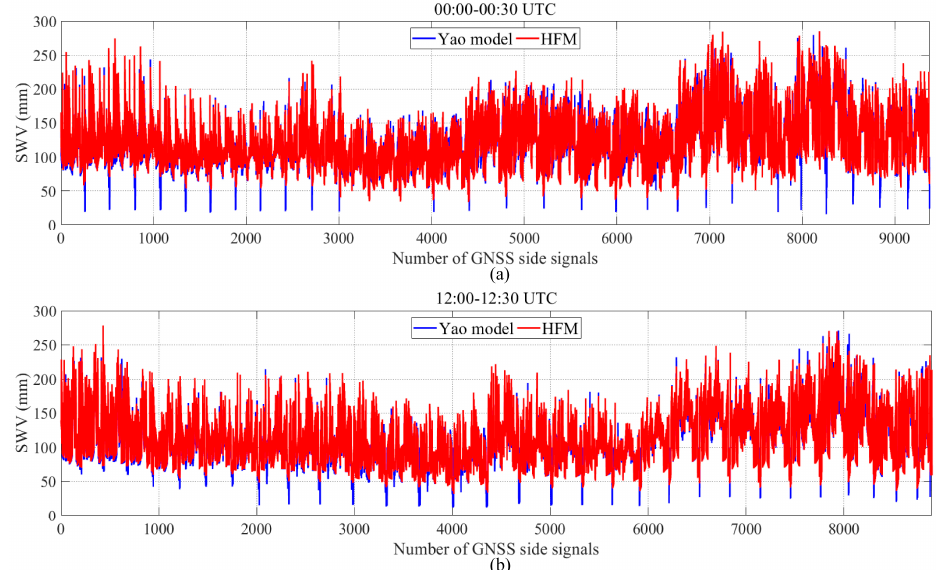
Figure 14. Comparison of the SWV value of effective side rays obtained from the Yao model and the HFM for two tomography epochs. (a) 00:00-00:30 UTC; (b) 12:00-12:30 UTC.